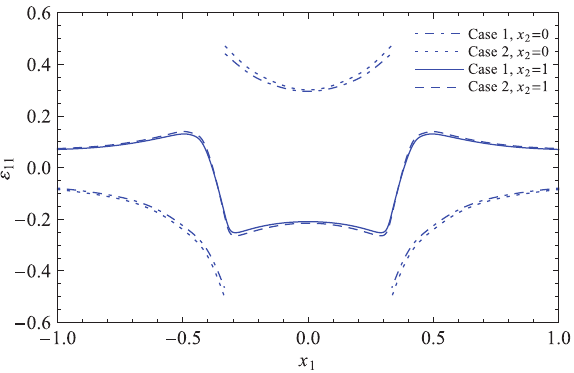
= 0, while the stress component σ Figure 6. Along x 2 continuous across the QD-barrier interface ( ± 1/3, 0, 0), the strain component ε has a jump there. Meanwhile, both 11 = 1 (midway between two QDs), ε and σ along the line x 11 11 2